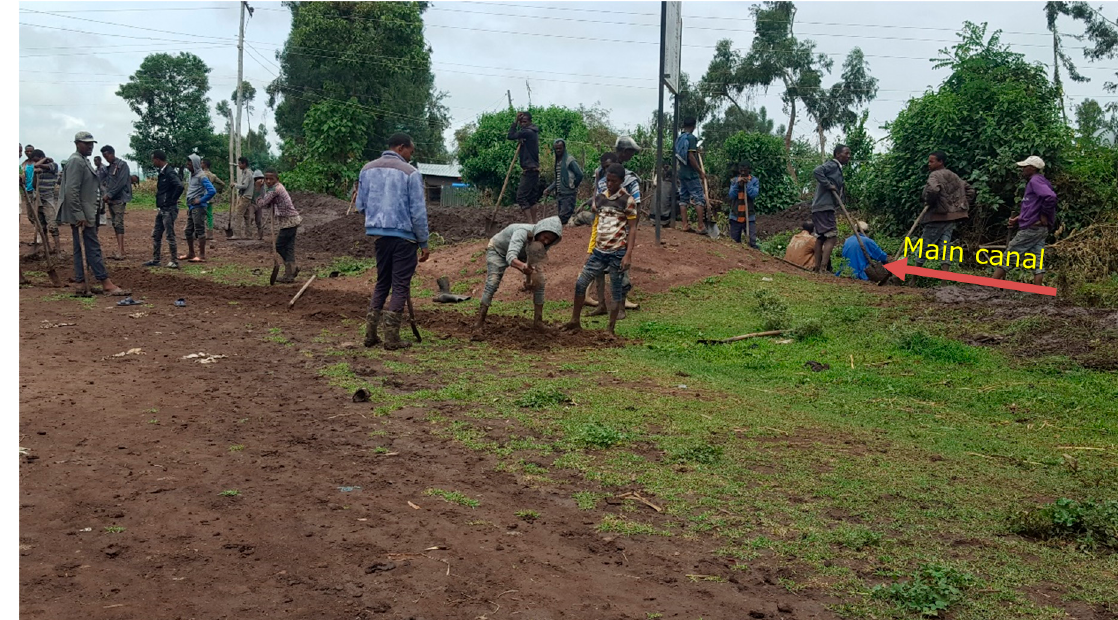
Figure 1. Farmers at the Ketar irrigation scheme diverting surface runoff to prevent sediment from entering the main canal, 25 August 2018.